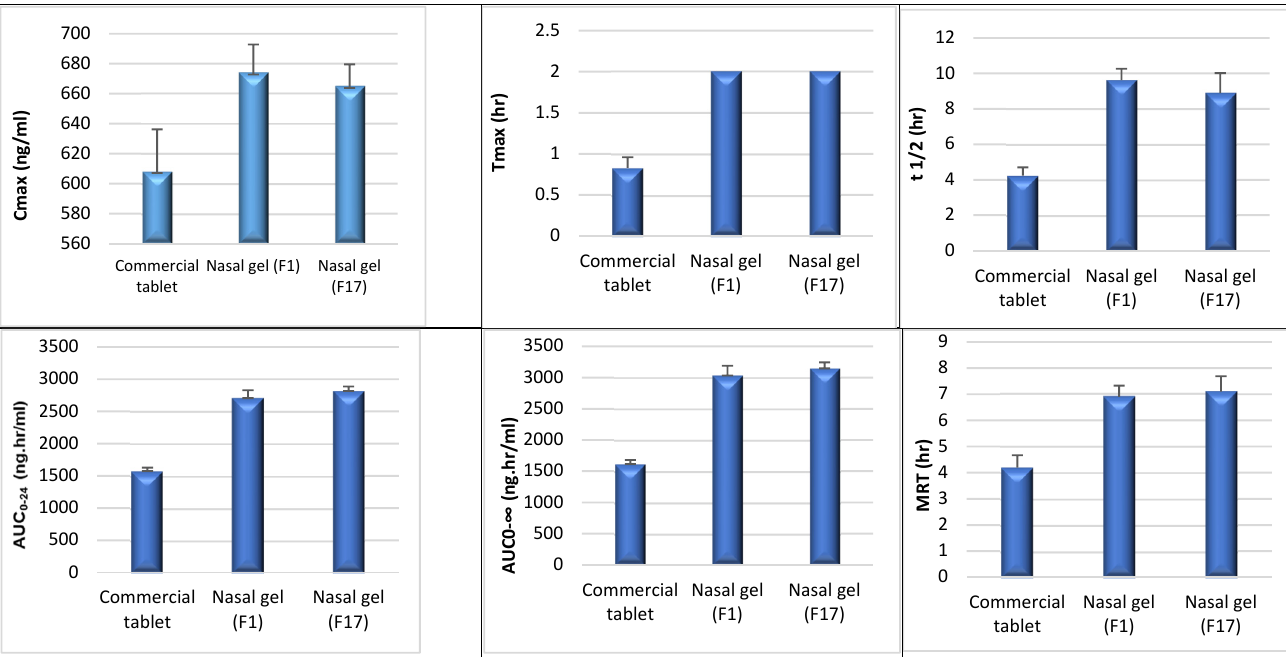
P1 comparison between commercial tablet and nasal gel (F1); two comparisons between commercial tablet and nasal gel (F17); P3 comparison between nasal gel (F1) and nasal gel (F17); * Significant difference.